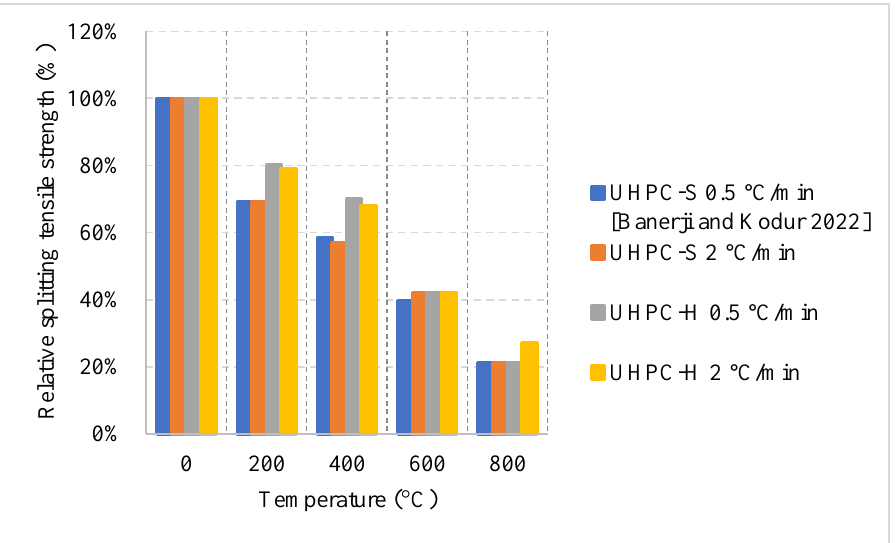
Figure 29. Relative compressive strength of UHPC under different heating rates. S: Steel Fiber, H: Hybrid between steel and Polypropylene Fibers [97].